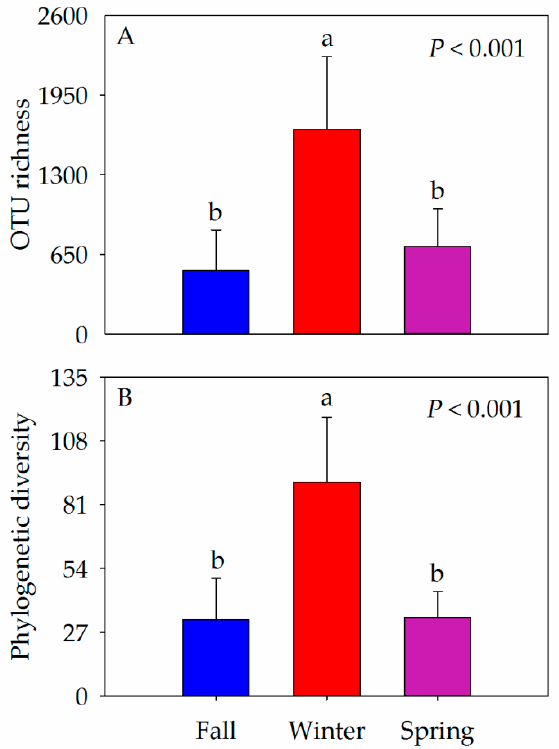
Figure 2. Gut bacterial alpha-diversity (A: OTU richness; B: Phylogenetic diversity) of different seasons. Different letters represent significant differences from one-way ANOVA by Tukey's HSD comparisons ( P < 0.05). Bars represent mean; error bars indicate standard deviation.